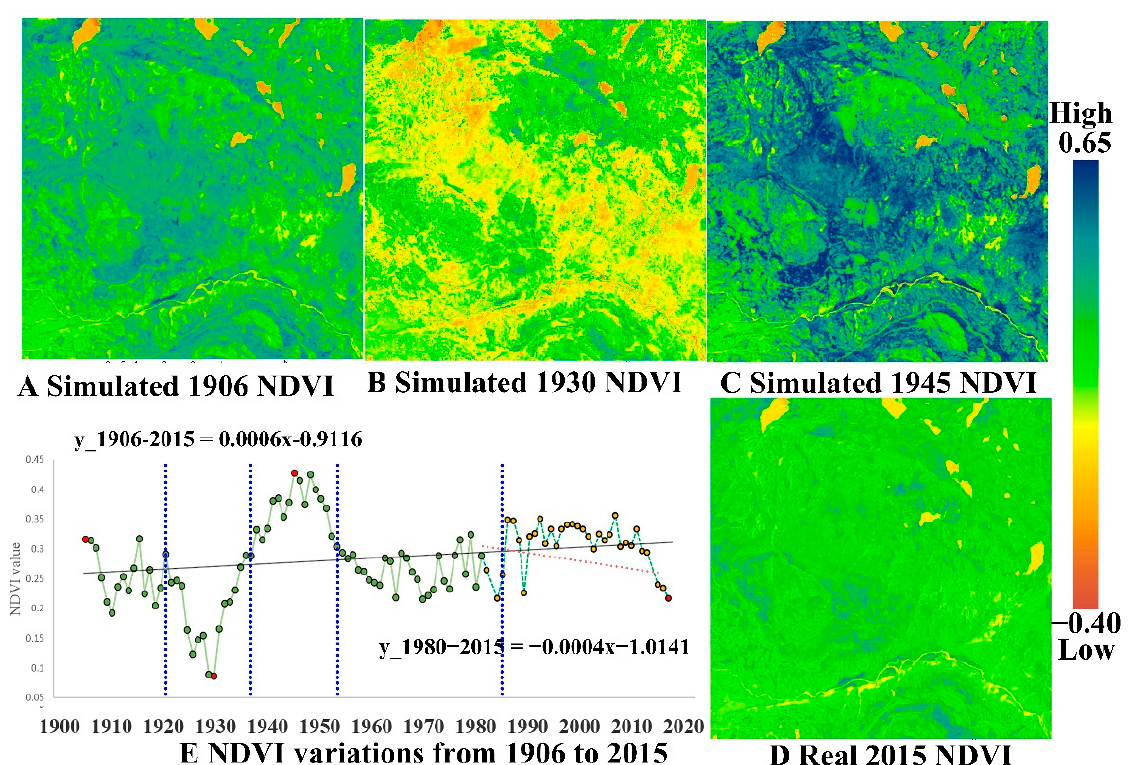
Figure 2. The simulated NDVI images for ( A ) 1906, ( B ) 1930, ( C ) 1945, and ( D ) real NDVI in 2015. ( E ) Distribution of the median NDVI values for the annual NDVI maps where the red dots correspond to the NDVI maps in 1906, 1930, 1945, and 2015. The green dots in the plot represent the simulated data from 1906 to 1979, and the yellow dots represent the real data from 1980 to 2015. The gray solid line and red dash line are the tendency lines from 1905 to 2015 and from 1980 to 2015, respectively. The outliers (2012) were excluded due to the lack of available satellite images. The blue dashed lines represent the four breakpoints of a regime shift.